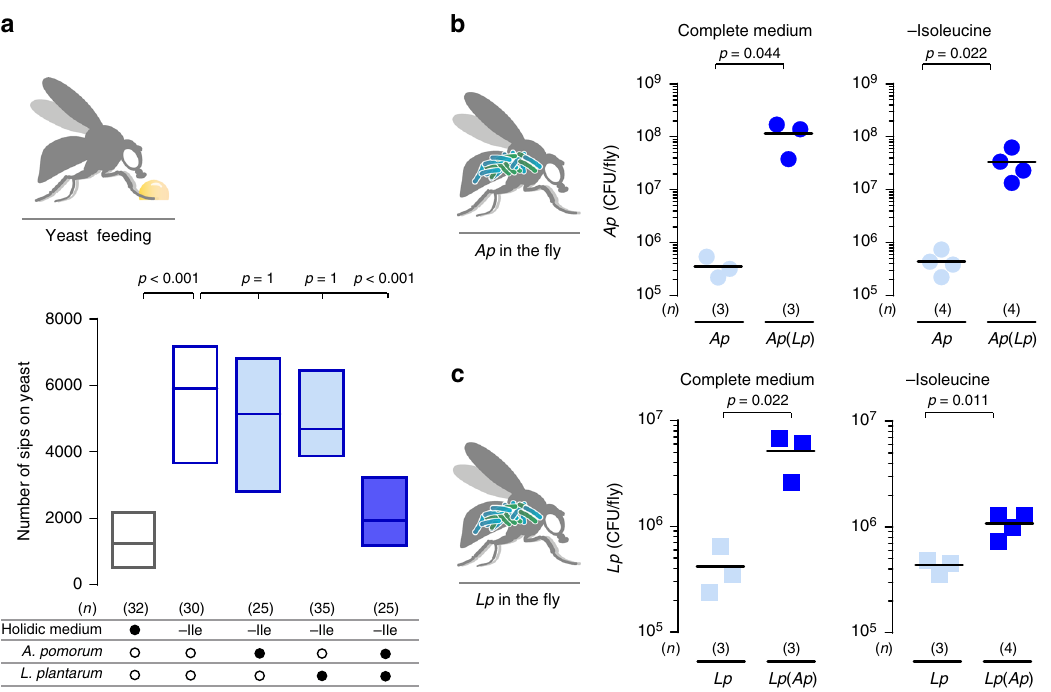
Fig. 1 Ap / Lp biassociation reduces yeast appetite and promotes bacterial growth independently of dietary Ile content. a Number of sips on yeast of fl ies kept in complete holidic medium or medium without Ile (-Ile) that were monoassociated (light blue) with Ap or Lp , or biassociated (dark blue) with both commensal species. Empty boxes represent germ-free conditions and fi lled boxes represent bacteria-associated conditions. Boxes represent median with upper and lower quartiles. n represents the number of fl ies assayed per condition. Signi fi cance was tested using a Kruskal – Wallis test with Dunn ’ s multiple comparison test. Filled black circles represent a complete holidic medium or association with speci fi c bacteria. Open black circles represent the absence of speci fi c bacteria. b , c Number of Ap (circles, b ) and Lp (squares, c ) colony-forming units (CFUs) from extracts of monoassociated (light blue) and biassociated (dark blue) fl ies kept in complete holidic medium, or medium lacking Ile (-isoleucine). Ap and Lp label data points represent the number of CFUs detected in monoassociated fl ies and Ap ( Lp ) and Lp ( Ap ) the measurement of Ap or Lp in biassociated fl ies. Each data point represents the number of CFUs detected in independent fl y extracts ( n ), and the black line represents the mean. Signi fi cance was tested using an unpaired two-tailed Student ’ s t test. Source data are provided as a Source Data fi speci fi c appetite for yeast (the main protein source for fl ies; Fig. 1a and Supplementary Fig. 1a) and that the fl y microbiome